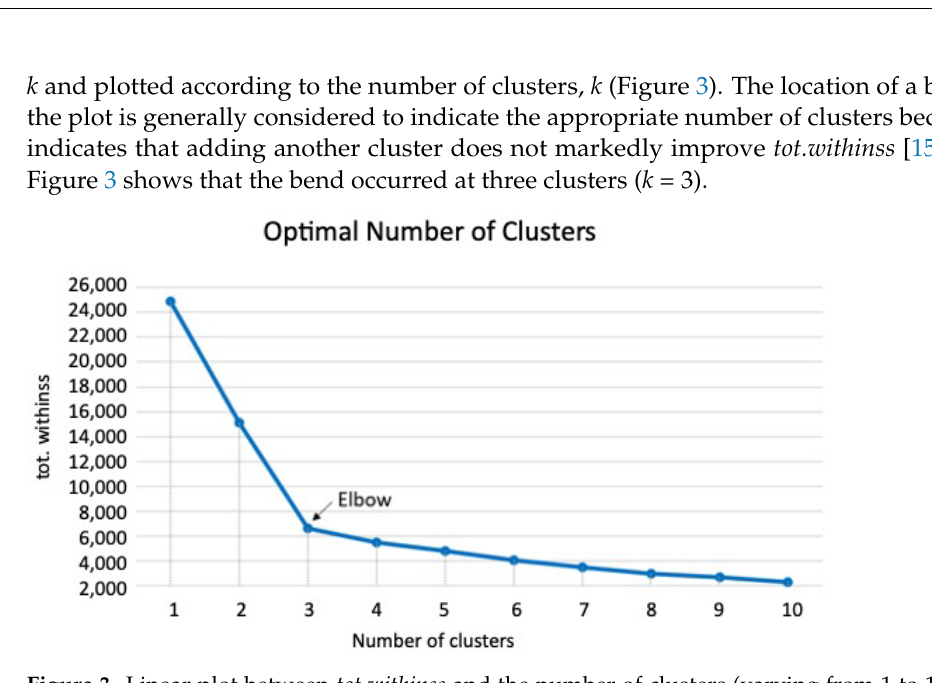
Figure 3. Linear plot between tot.withinss and the number of clusters (varying from 1 to 10). The bending point is located at k = 3, which represents the optimal number of clusters.